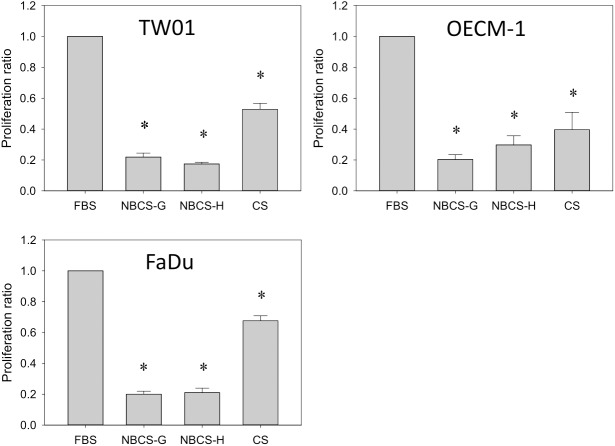
Newborn calf serum did not provide favorable conditions for the growth of head and neck cell lines.The proliferation of cells cultured in NBCS and CS at 72 h was presented as the relative proliferation ratio of cells in FBS (1.0-fold). Data indicate the average value of triplicates (mean ± SD). *:p<0.001 compared with cells cultured in FBS. NBCS-G: Gibco NBCS; NBCS-H: HyClone NBCS.